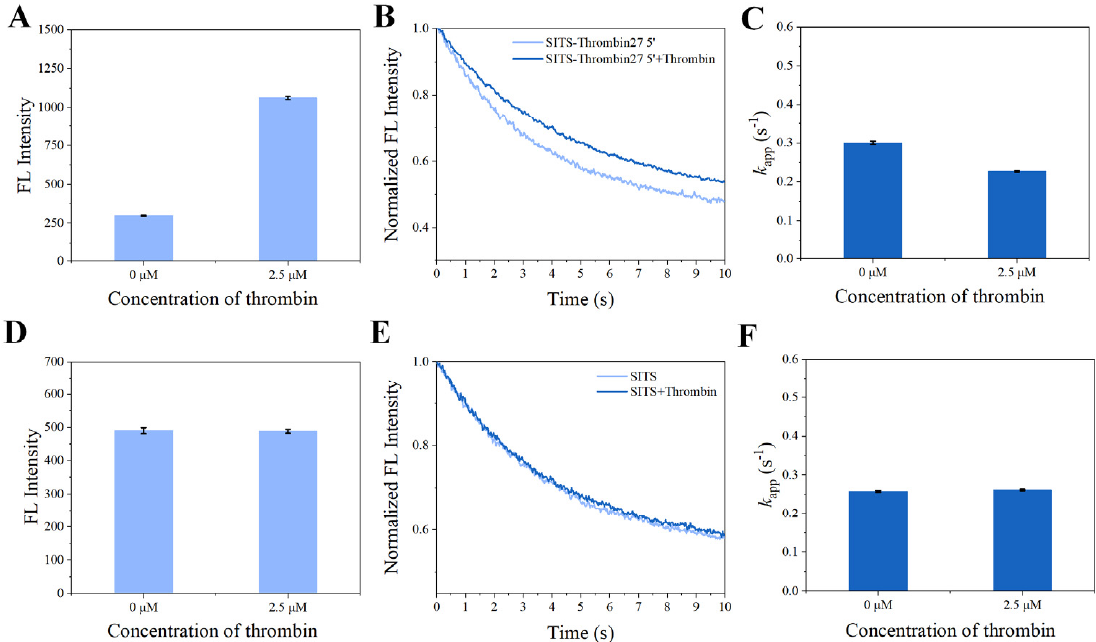
Figure 4. Evaluation on nonspecific stilbene interactions. Fluorescence intensity of SITS-Thrombin27 5 (cid:48) ( A ) and SITS ( D ) in the presence of thrombin. Fluorescence attenuation curves of SITS-Thrombin27 5 (cid:48) ( B ) and SITS ( E ) ( λ ex = 333 nm, λ em = 426 nm) and corresponding k app values of SITS-Thrombin27 5 (cid:48) ( C ) and SITS ( F ) upon the addition of